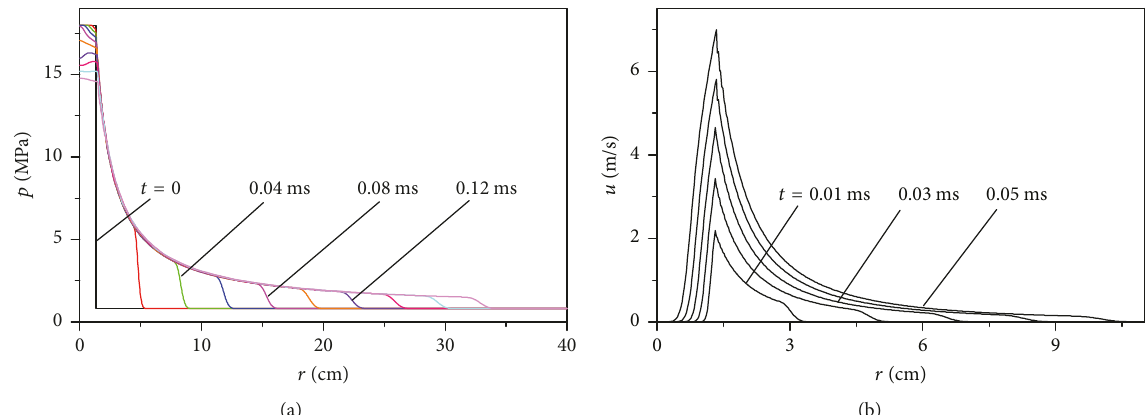
Figure 3: Propagation of elastic compression wave into liquid lead: (a) pressure; (b) velocity.